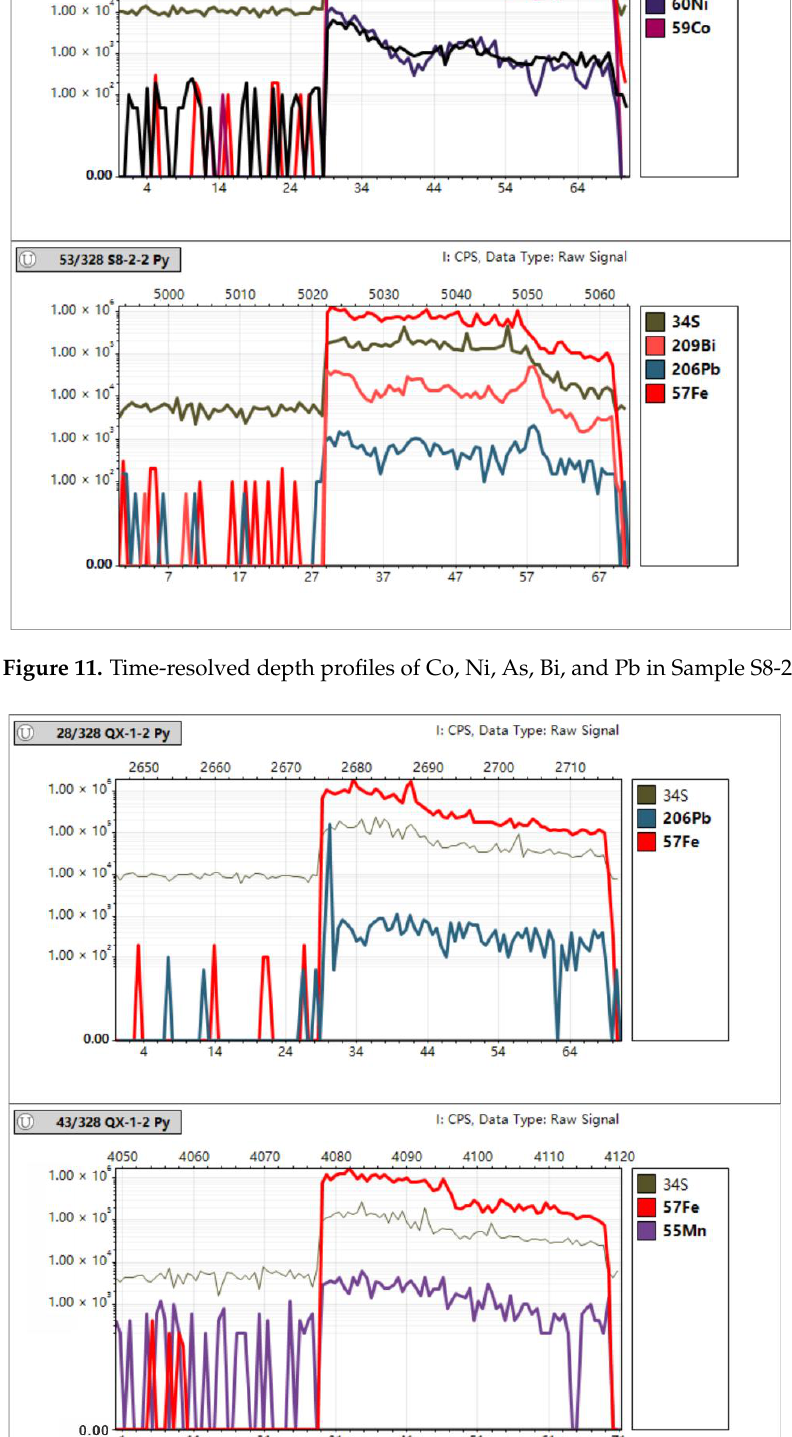
Minerals 2022 , 12 , 489